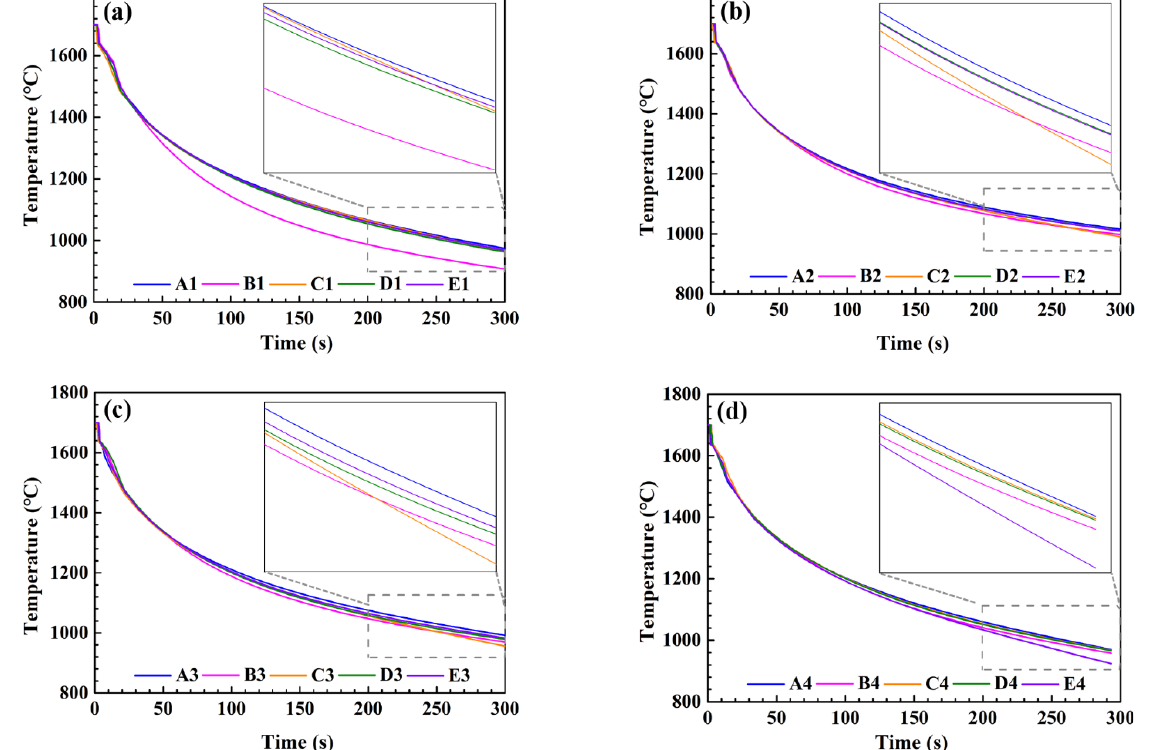
Figure 9. Temperature variation in the isolated liquid phase zones and their surrounding areas: ( a ) alloy I; ( b ) alloy II; ( c ) alloy III; ( d ) alloy IV. ( a ) alloy I; ( b ) alloy II; ( c ) alloy III; ( d ) alloy